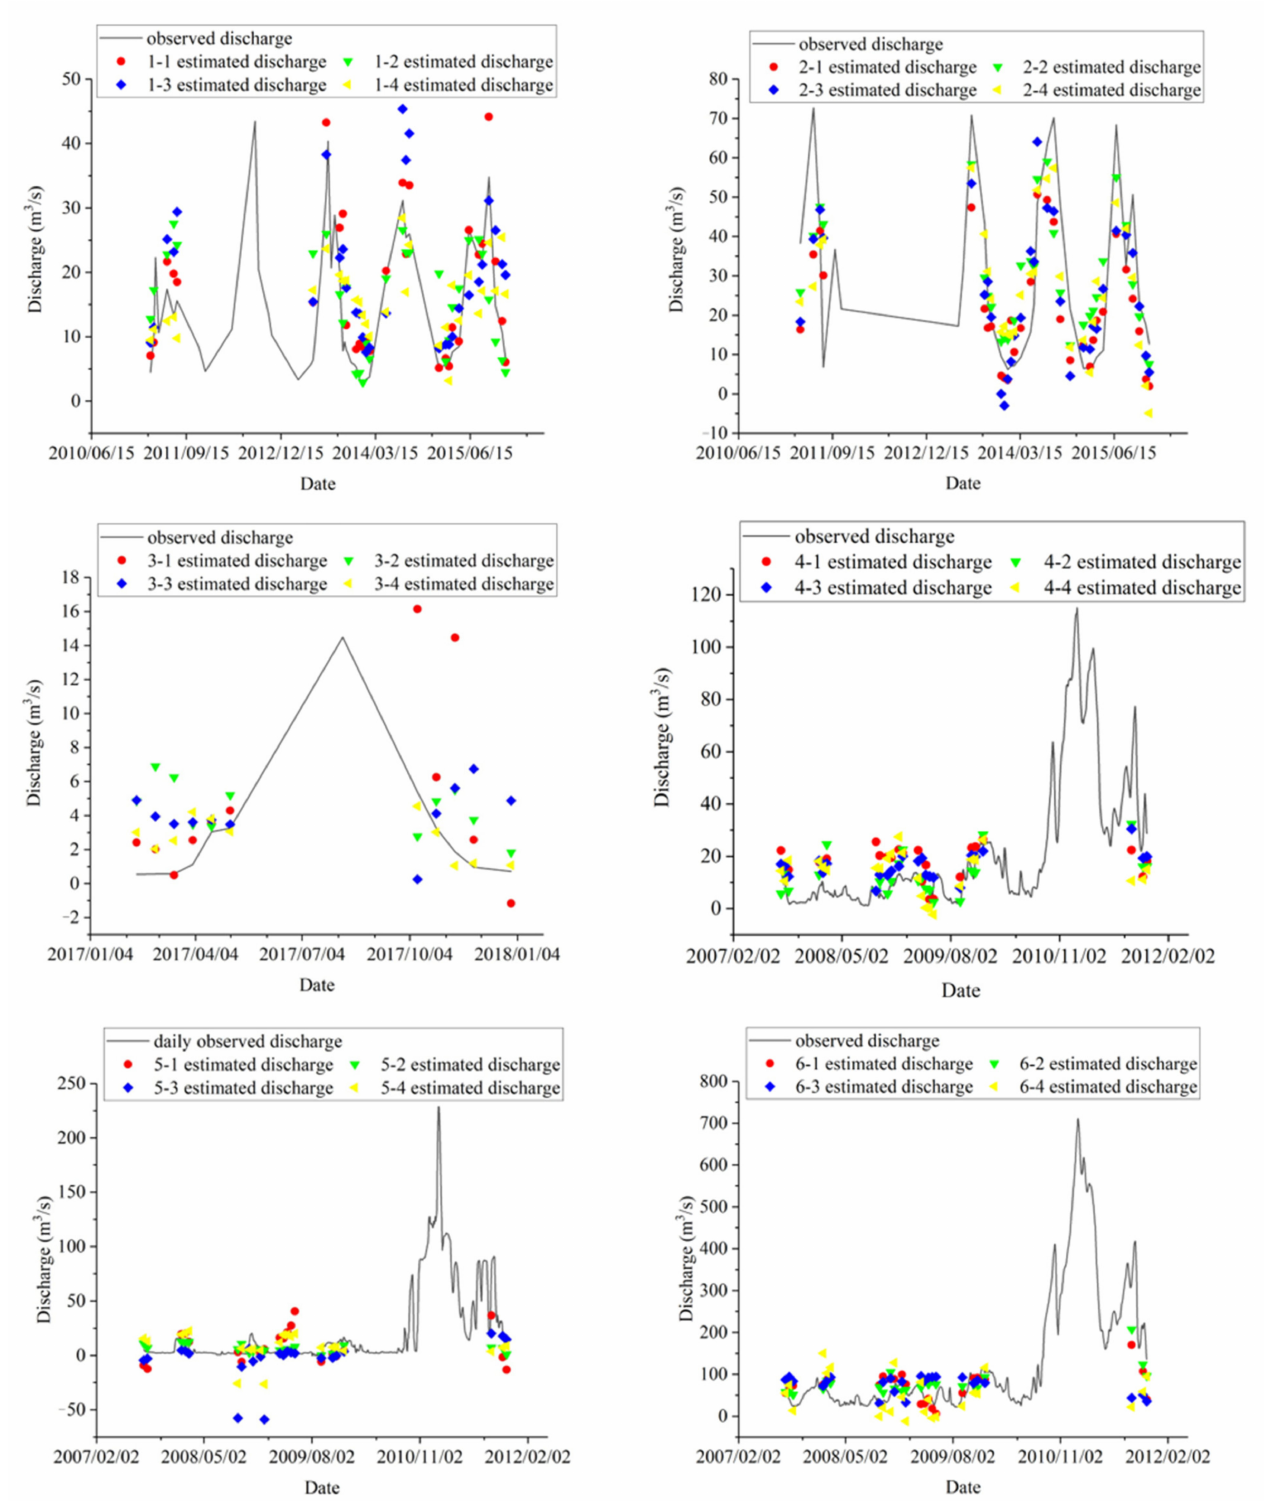
Figure 6. Estimated discharge and the observed discharge of each hydrological gauge for the validation